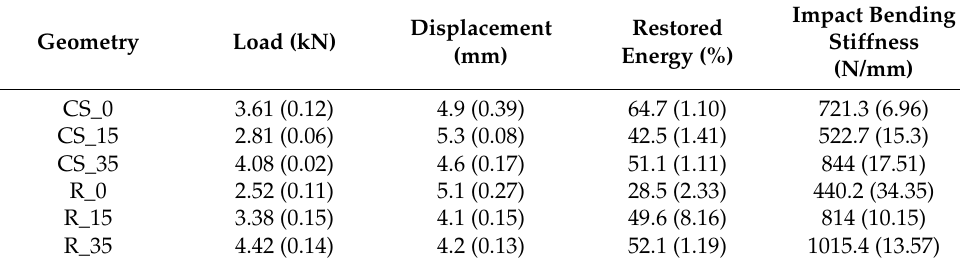
Table 1. Results obtained for the different impact